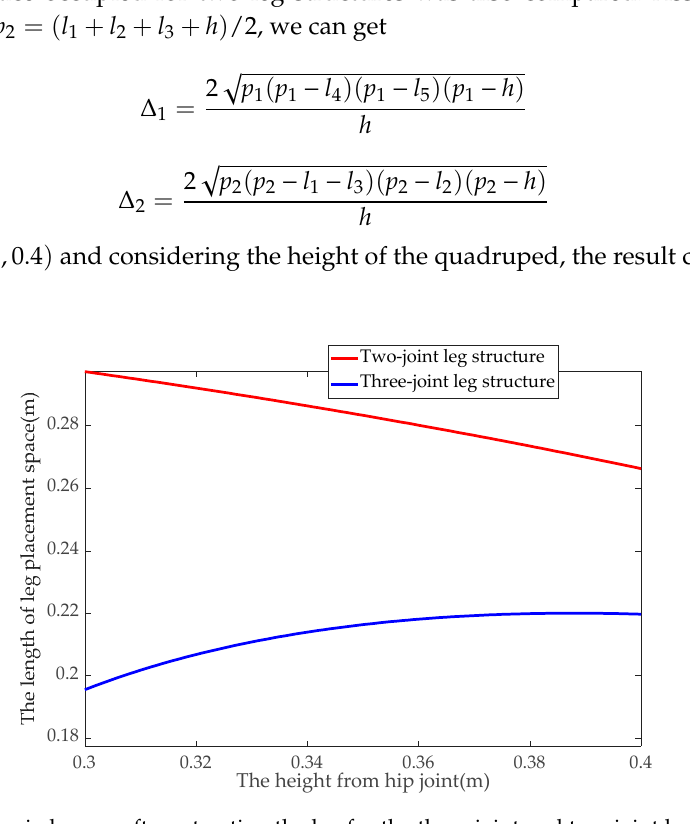
Figure 3. Obstacle avoiding ability of the three-joint and two-joint leg structures.